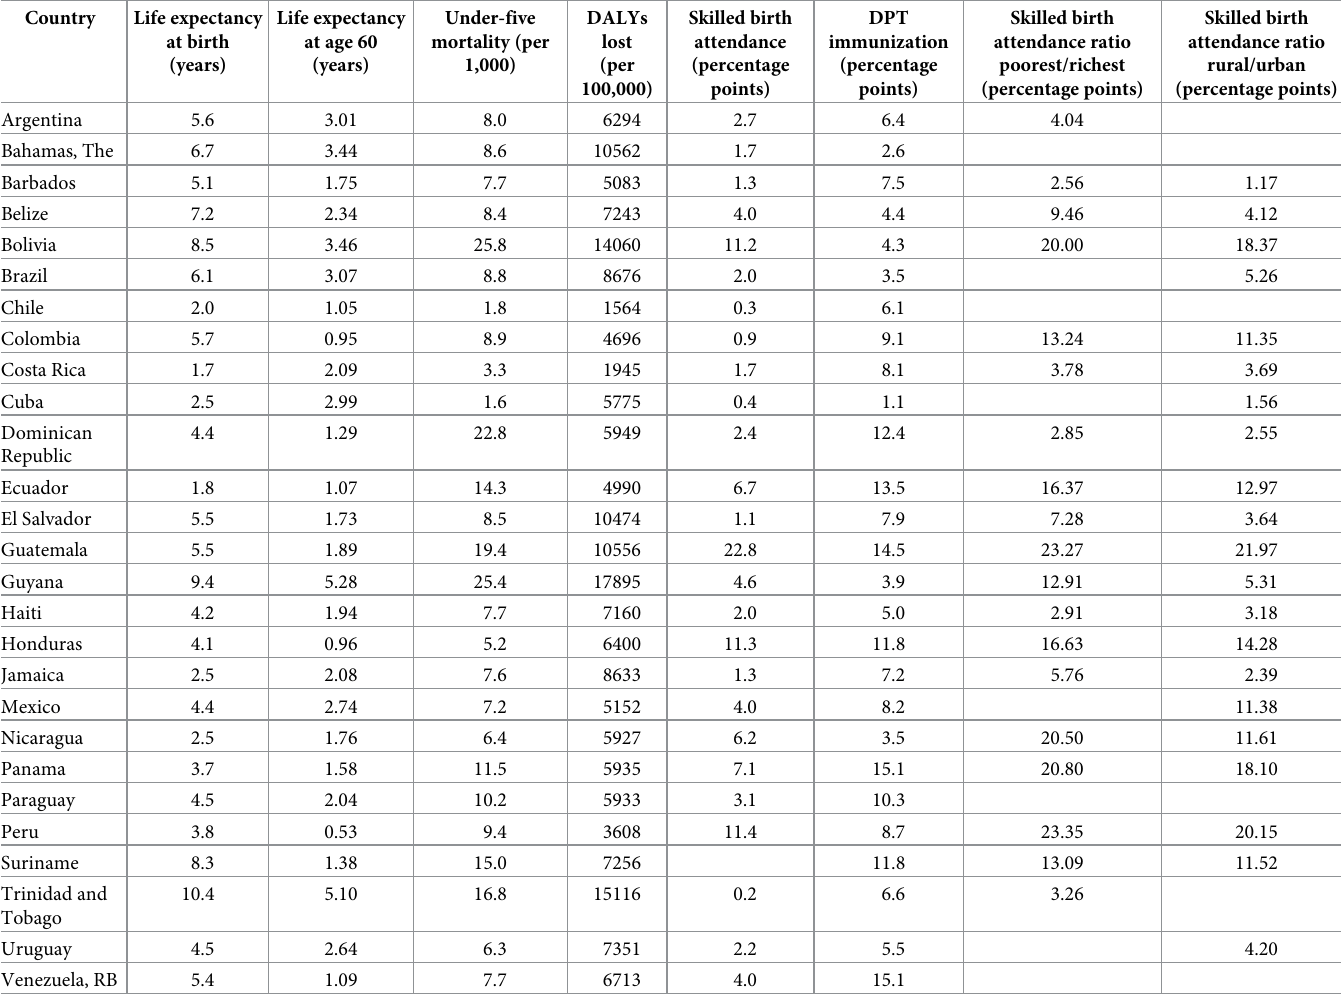
Table 1. Potential gains estimated by output